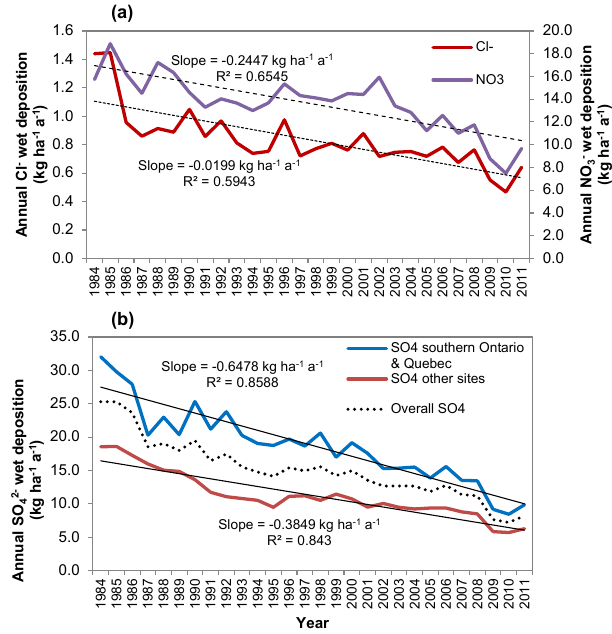
Figure 7. Temporal trends of annual wet deposition of Cl − and (a) and SO 2 − (b) NO − 3 4